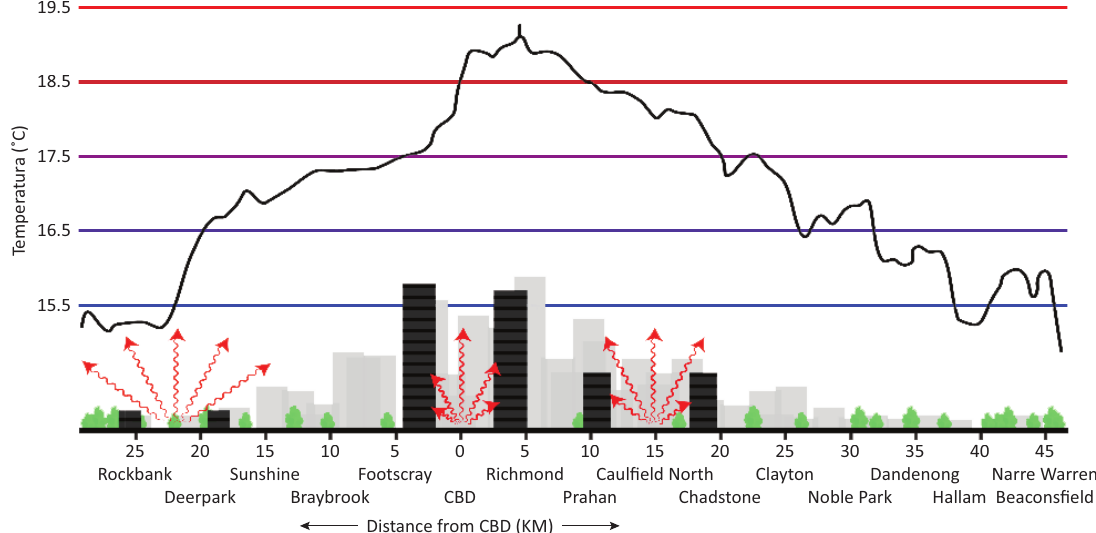
Figure 1. This diagram shows temperature and urban form relationship by way of a longitudinal cross-section through Greater Melbourne overlaid with temperature readings (taken on a clear summer night) from outer western suburbs, through the CBD to the outer south-eastern suburbs (based on diagram from City of Melbourne’s Urban Forestry Strategy (Melbourne,